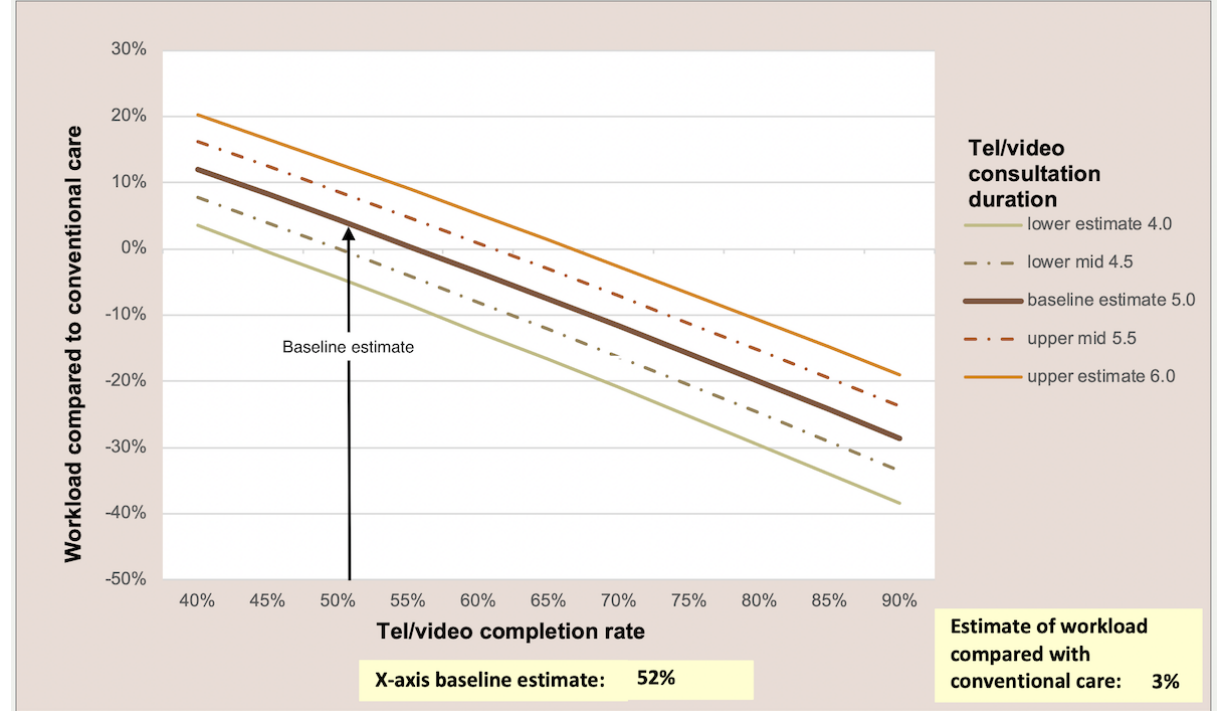
Figure 2. Impact of telephone consultations on general practitioner workload: varying telephone completion rate and call